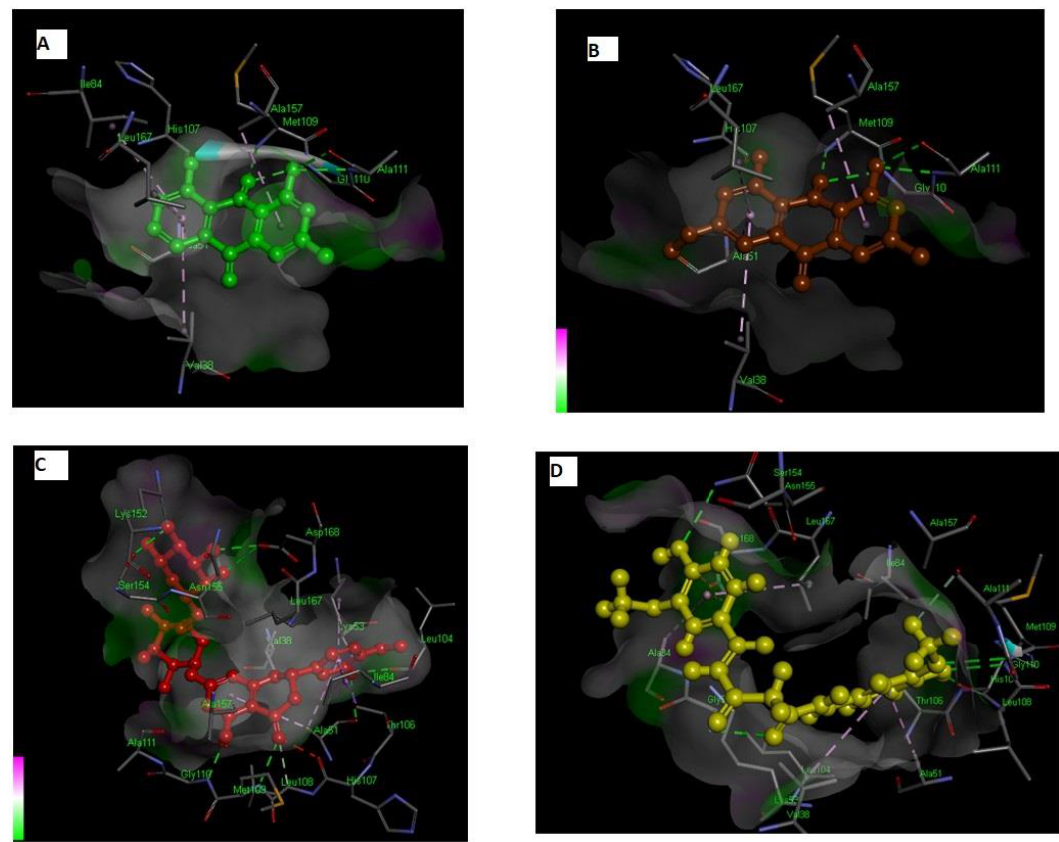
Figure 6. Molecular interactions of chrysophanol ( A ), physcion ( B ), hesperidin ( C ) and curcumin ( D ) with p38 α MAPK (PDB ID: 2QD9).